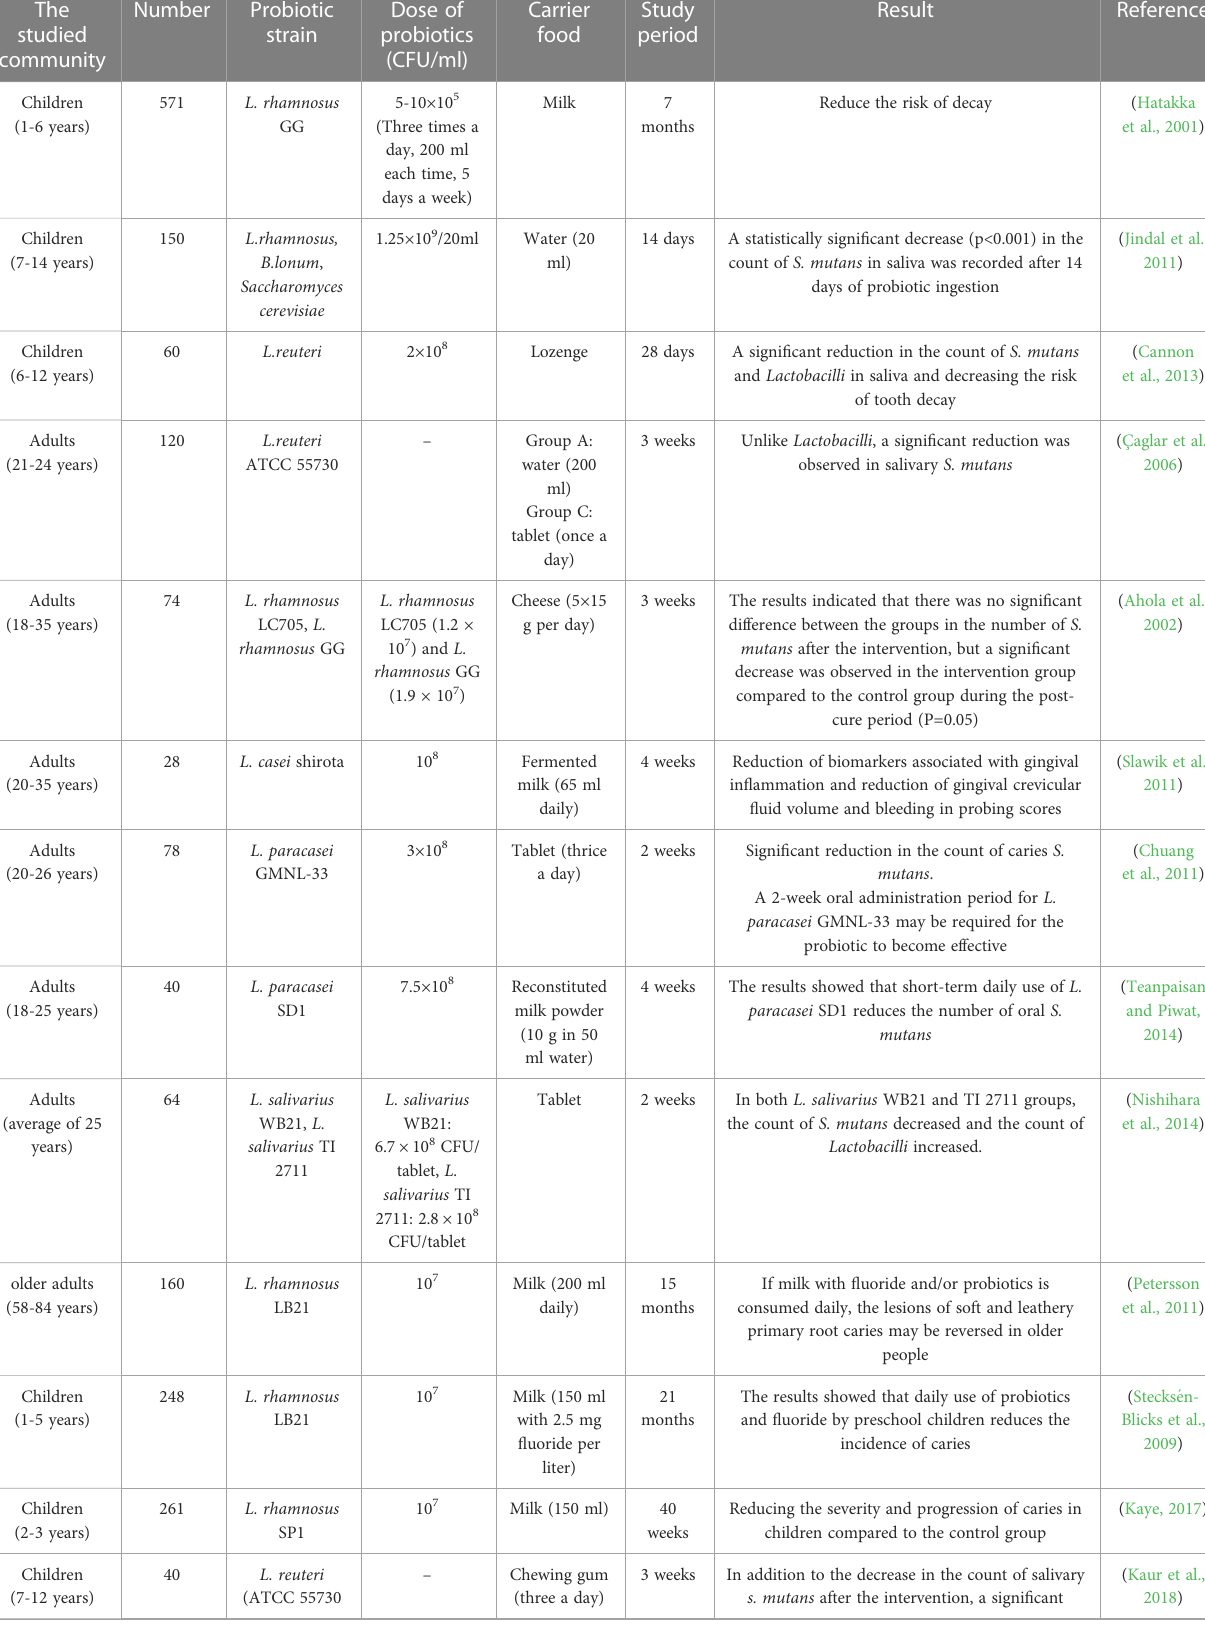
TABLE 1 Human in vivo studies on the effect of Lactobacilli on oral